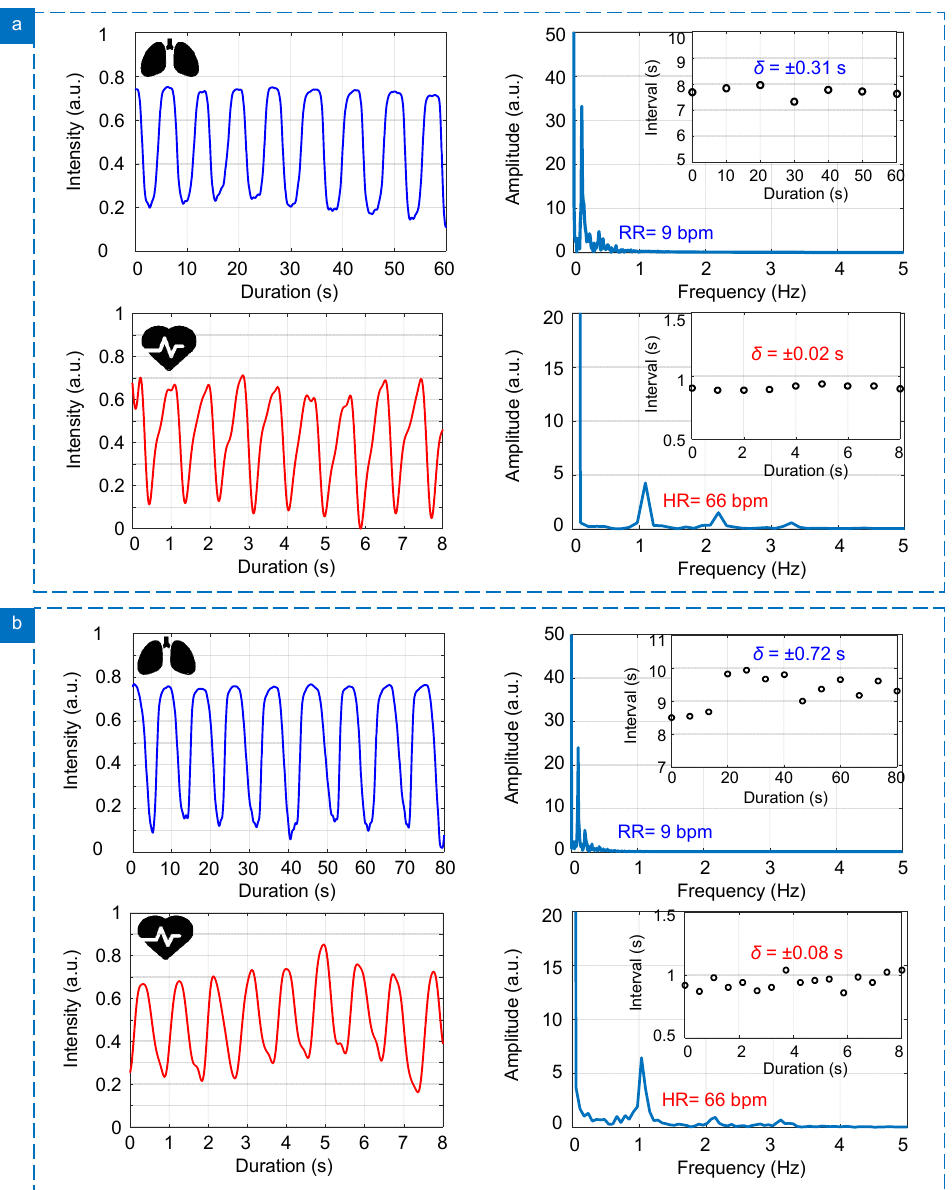
Fig. 10 | Vital signs monitoring results using the TMF in-line interferometer, including the recovered respiration and heartbeat waveform, obtained RR (9 bpm) and HR (66 bpm) and interval errors (a), and the same results regarding the four-mode fiber interferometer